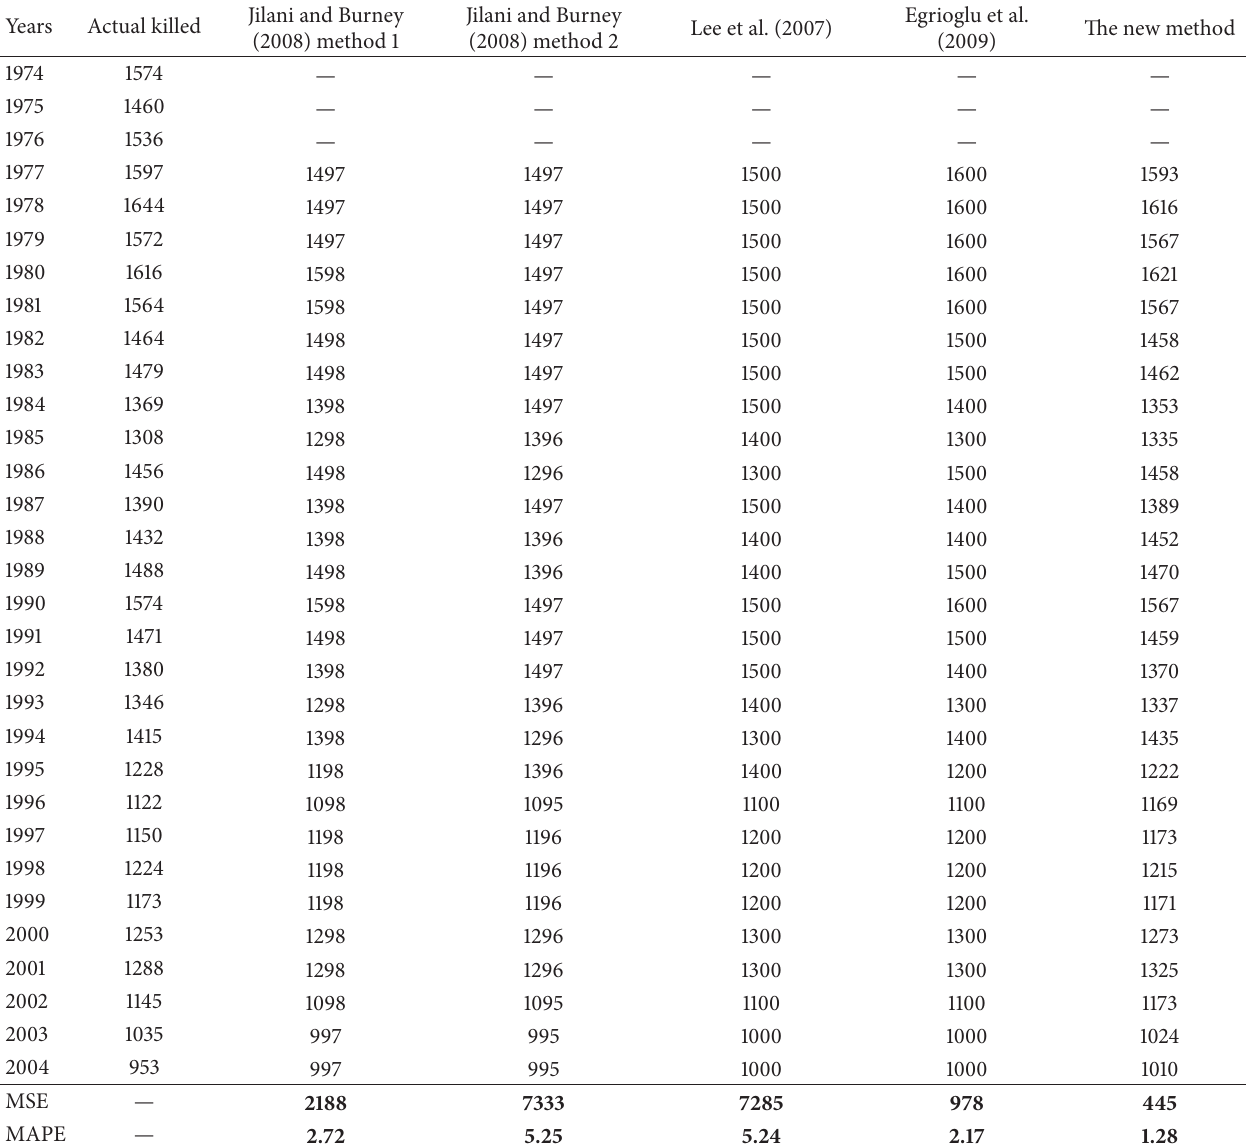
Table 2: The comparison of the forecasting results between the new method and other methods for yearly car accident casualties in Belgium from 1974 to